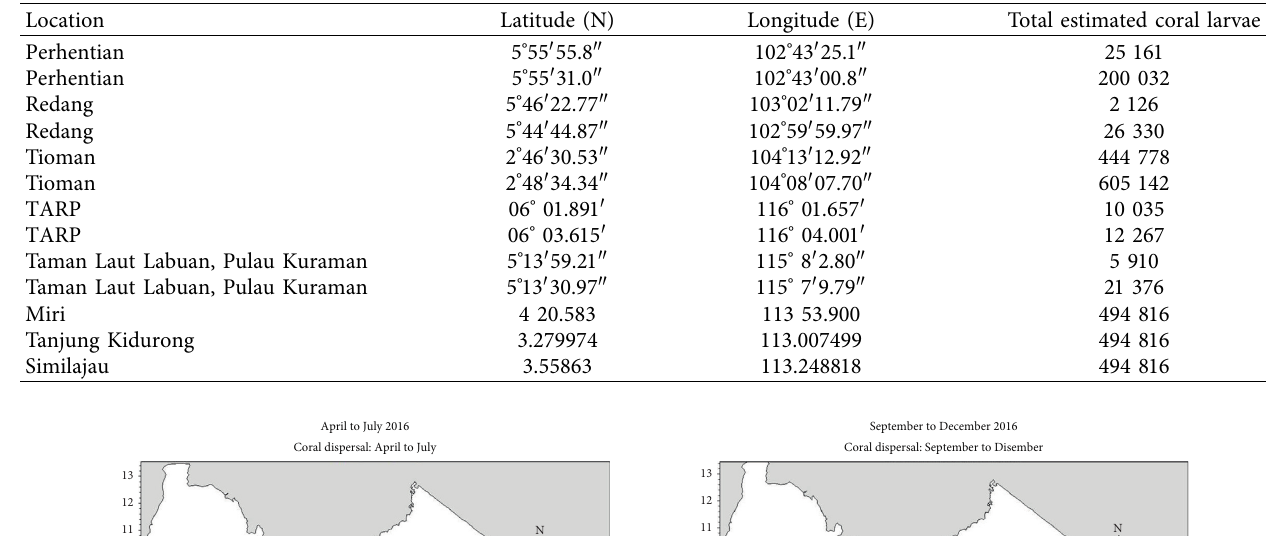
Table 1: Coral seeding data from 8 sites.